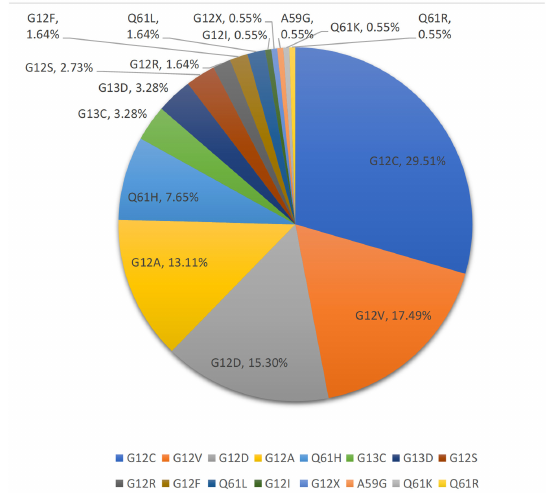
Figure 1. The proportion of KRAS-mutation subtypes . Molecular profiles of KRAS-mutant NSCLC were sequenced with 68 lung can- cer-related gene NGS. This showed that TP53 was the most frequent co-mutation in our study population (59.6%, 109/183 cases), followed by STK11 (18.6%, 34/183 cases). In ad- dition, ATM (14.2%, 25/183 cases), PIK3CA (8.7%, 15/183 cases), and SMAD4 (5.5%, 10/183 cases) were common co-mutations. Figure 2 shows the molecular profiles of pa- tients diagnosed with advanced KRAS-mutant NSCLC classified based on gender, stage of disease, KRAS subtypes, smoking status, first-line treatment group, and PD-L1 ex- pression.